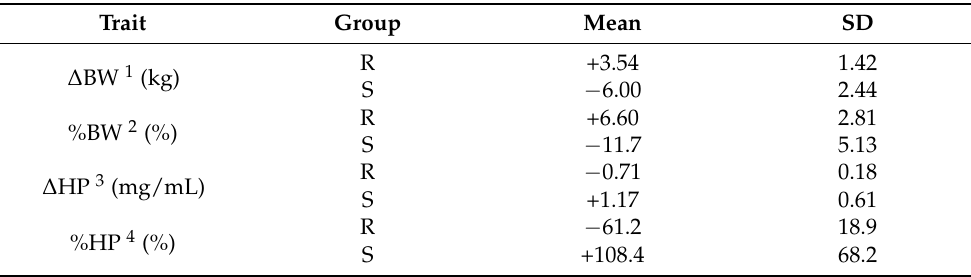
control pigs; 3 Haptoglobin increment at 4 DPV; 4 Ratio between ∆ HP and the basal level of hapto-